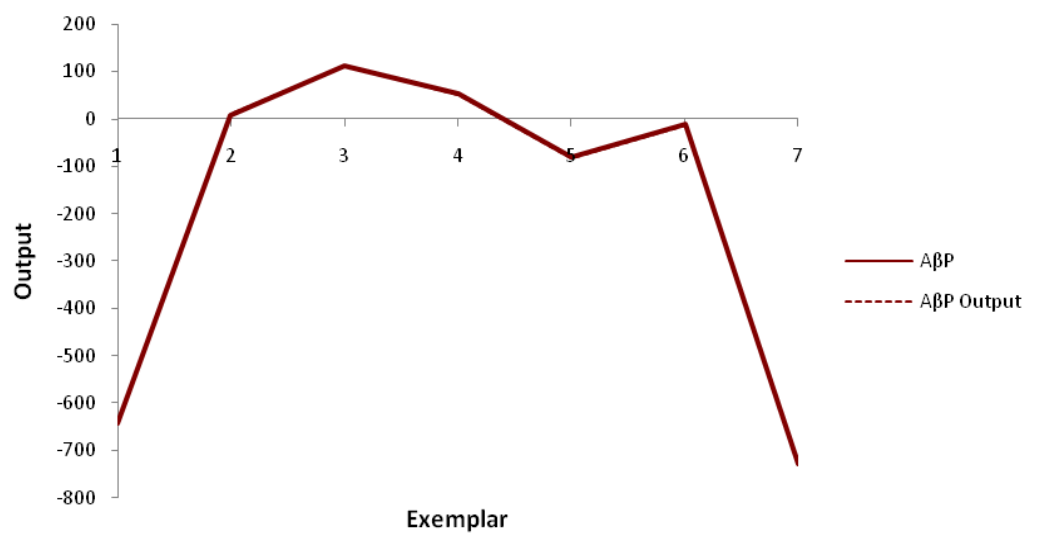
Figure 4. Mapping of correlation between desired and actual network